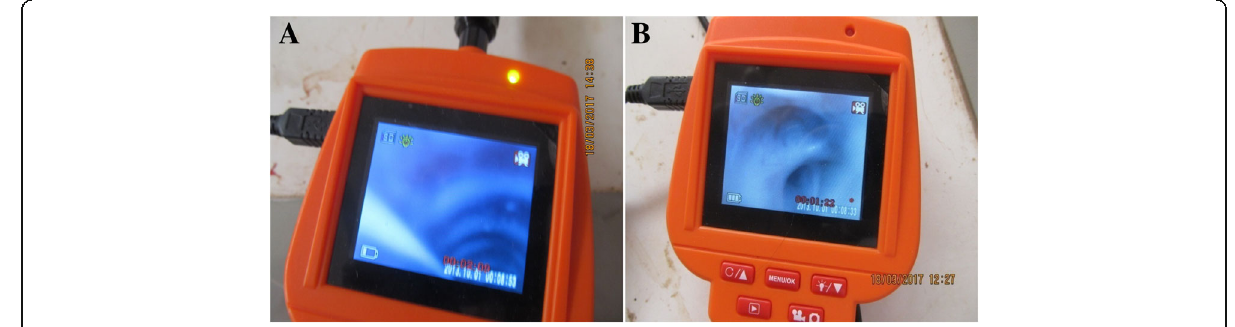
Fig. 3 Endoscopic visualization of the tracheal rings using VL in dogs ( a ) and the carina ( b )